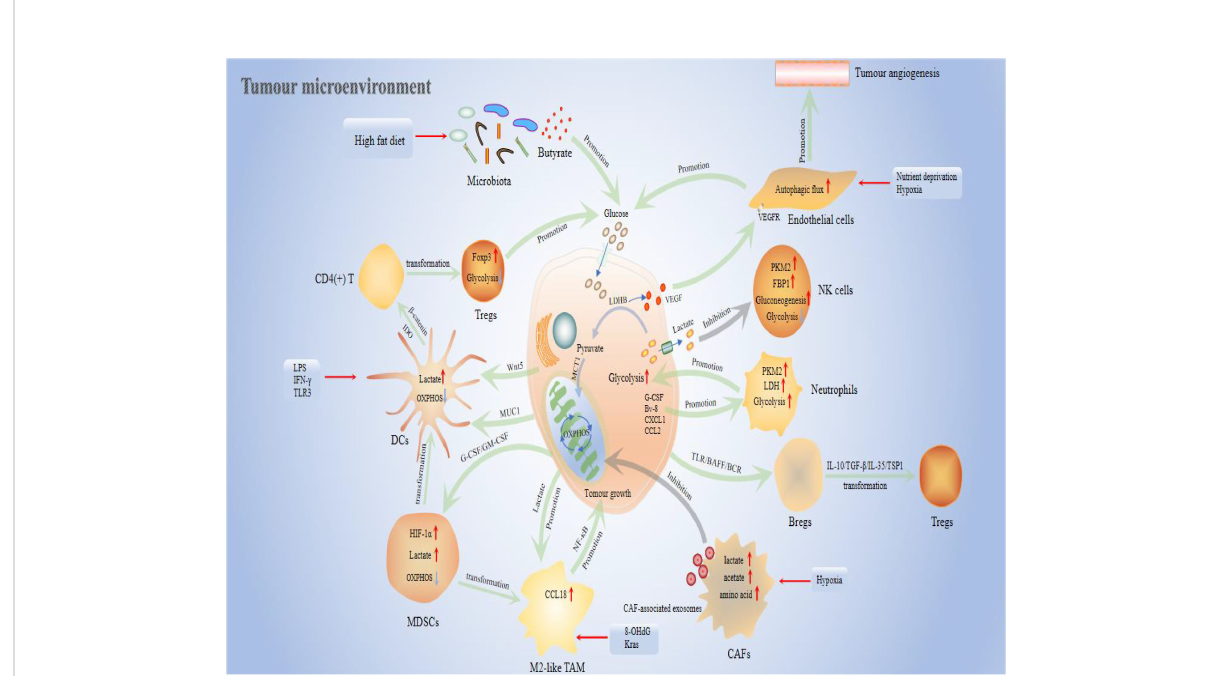
FIGURE 2 Metabolic crosstalk between PC cells and the TME. The fi gure completely shows the roles and pathways of important components in the TME in the glycolytic process, proliferation, and invasion of PC, including CAFs, TAMs, DCs, neutrophils, NK cells, Tregs, Bregs, endothelial cells, MDSCs, and